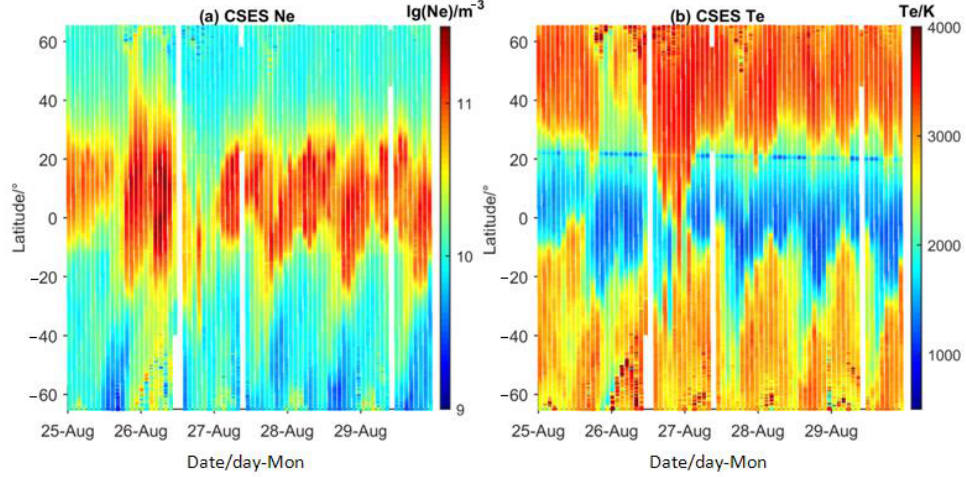
Figure 4. The electron density ( a ) and electron temperature ( b ) in local daytime from 25 to 29 August in 2018.